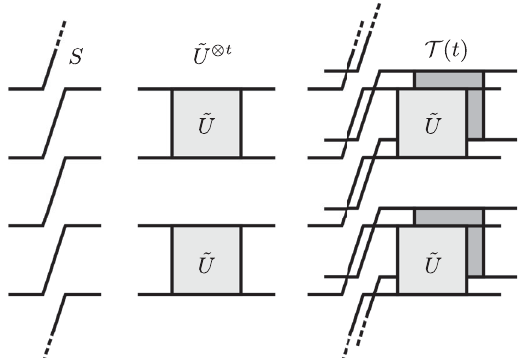
FIG. 8. Construction of the transfer matrix generating K ð t Þ ¼ j Tr W ð t Þj 2 , here for t ¼ 2 . The dashed lines exiting above and entering below are connected. Left: orthogonal matrix S .